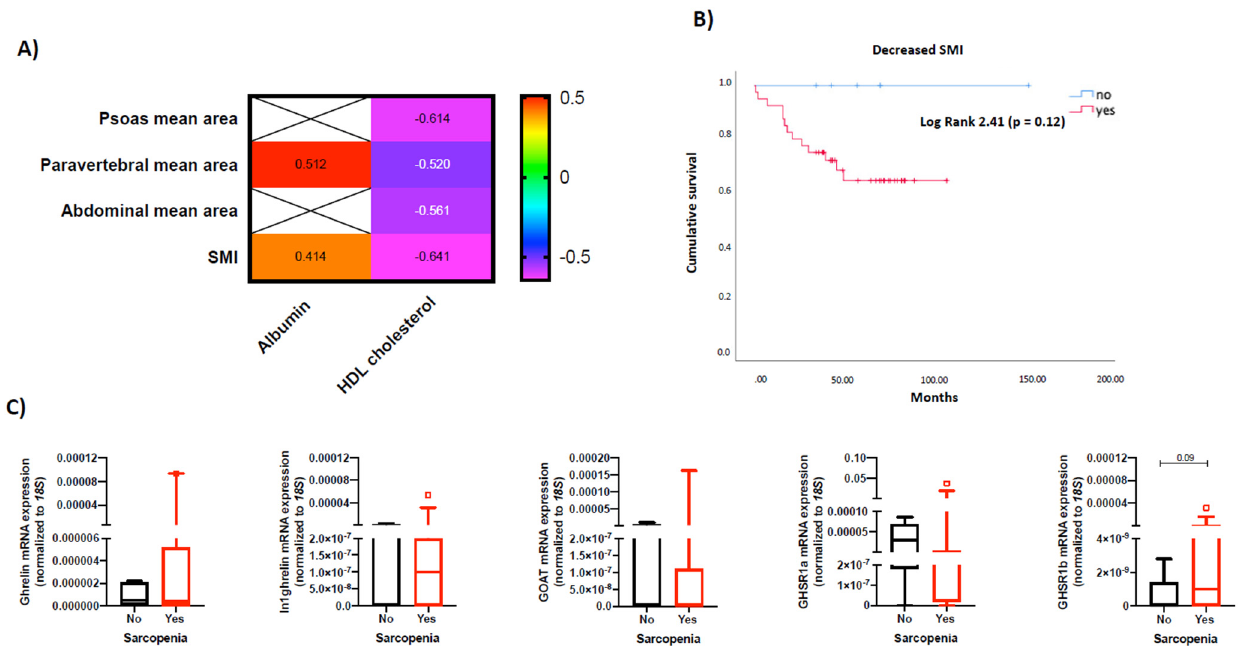
Figure 4. ( A ) Significant clinical/biochemical correlations between nutritional parameters and CT-measured muscle characteristics including SMI. ( B ) Cumulative survival curve for NEN patients according to the presence of sarcopenia at diagnosis using CT imaging. ( C ) Molecular expression of ghrelin system components in NEN tumor samples according to the presence of sarcopenia at diagnosis using CT scans.